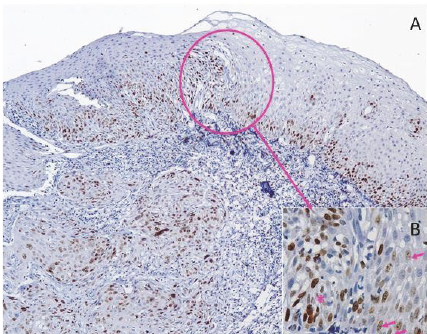
Figure 4: (A) Strong and diffuse immunoreactivity for Ki-67 in the region adjacent to the tumor (less magnification); (B) transition area. Arrows indicate nucleation markers for Ki-67 in the region adjacent to the tumor; asterisk marks tumor region (highest mag-